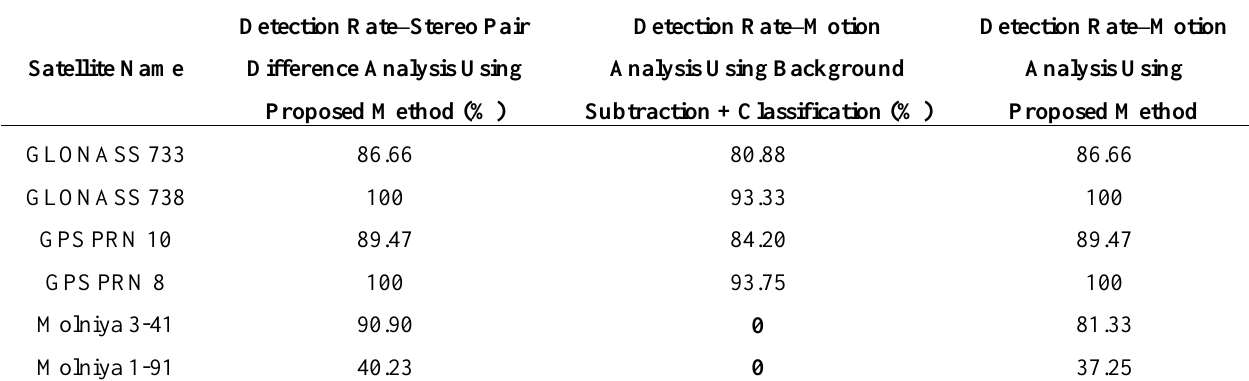
Table 3. Detection rates for multiple